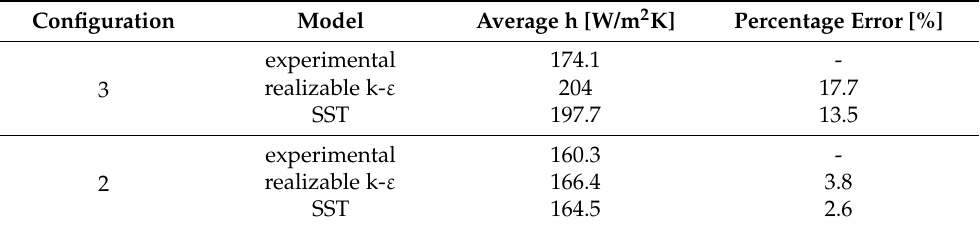
Table 5. Average heat transfer coefficient and percentage errors of the CFD models with respect the experiment of the multi slot jet configurations for H/B = 4.